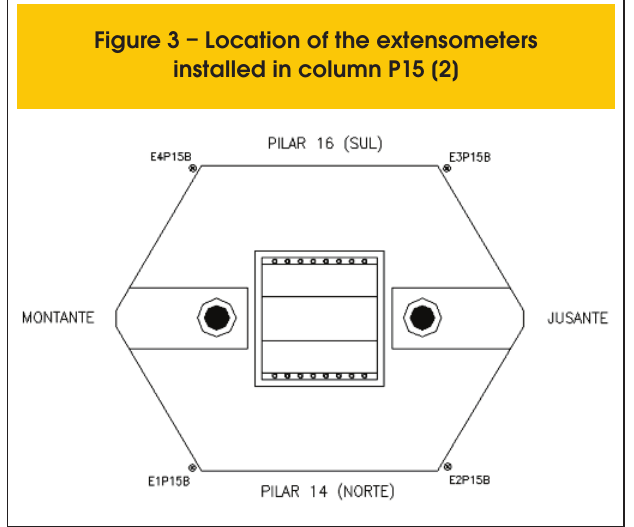
Figure 3 – Location of the extensometers installed in column P15